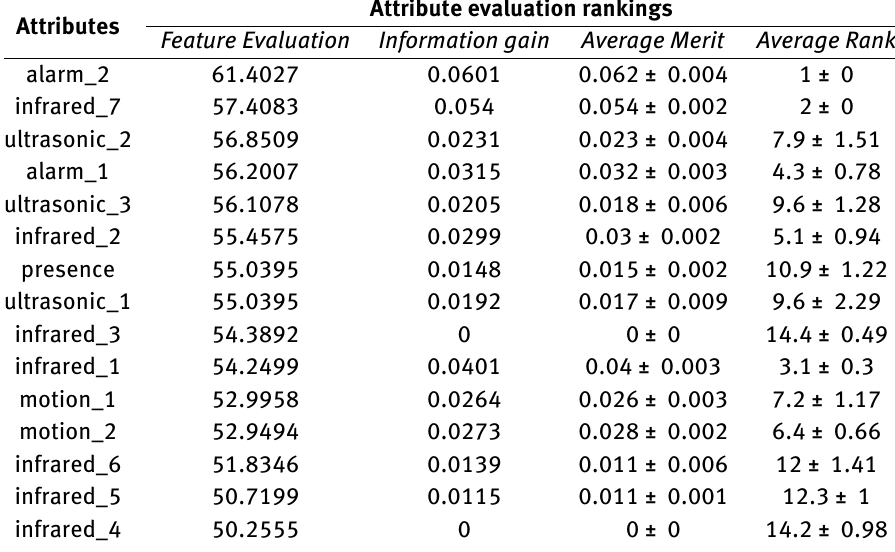
Table 7: Attribute Evaluation and Information Gain Rankings of X80-H in Position 2 Determining Traversal